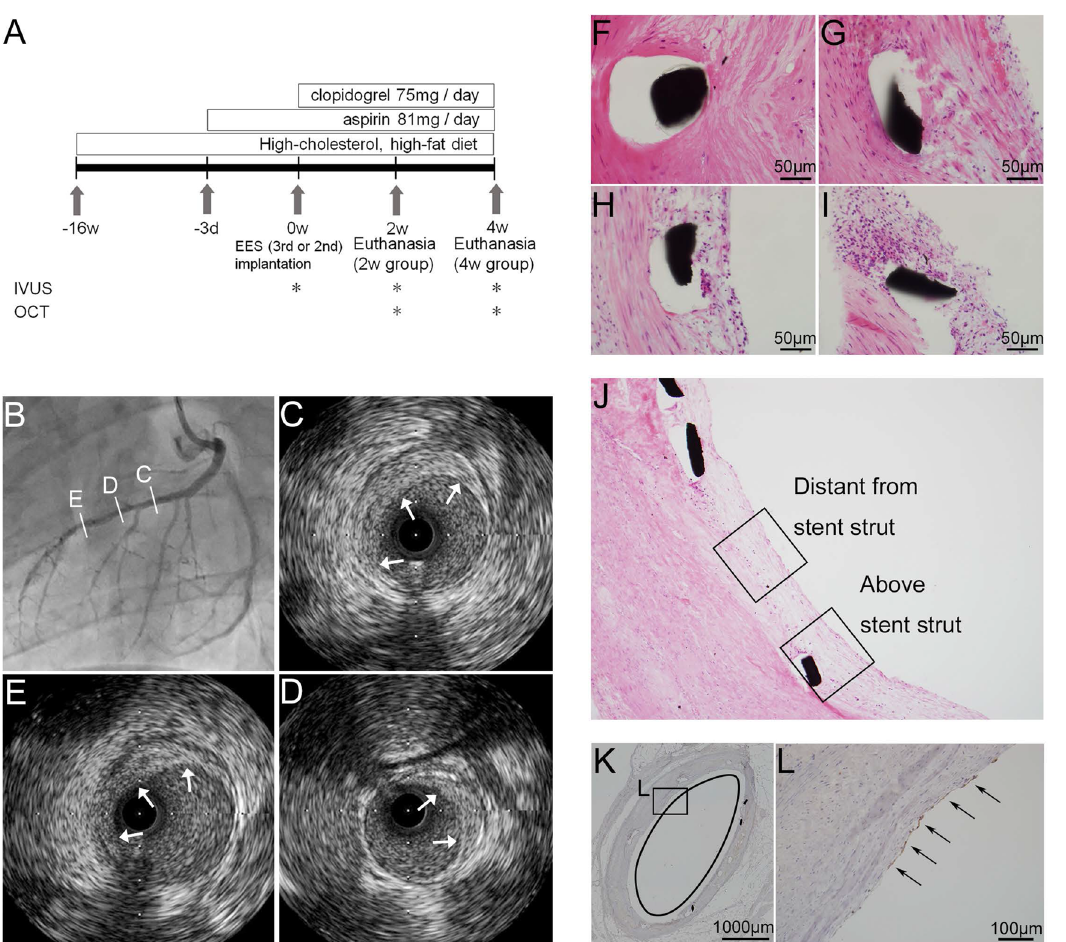
Figure 4. Protocols for animal experimentation and morphometrical analysis. ( A ) Outline of low-density lipoprotein receptor knockout (LDLR −/−) minipigs experiment. ( B – E ) Images of coronary arteries from LDLR −/− minipigs before stent implantation. ( B ) Angiographically, mild stenosis due to arteriosclerosis is visible. ( C – E ) Eccentric fibro-fatty plaques (arrows) are observed on intravascular ultrasound. ( F – I ) Grading of peri-strut inflammation for semi-quantitative analysis. ( F ) Grade 0, absent, few inflammatory cells. ( G ) Grade 1, mild, fewer than 20 inflammatory cells per high power field (HPF). ( H ) Grade 2, moderate, fewer than 50 inflammatory cells per HPF. ( I ) Grade 3, severe, more than 50 inflammatory cells per HPF. ( J ) Tissue characteristics are evaluated for the neointima above the stent strut and the neointima distant from the stent struts. ( K , L ) All sections of stented regions harvested from porcine coronary arteries are immunostained for anti-CD31 antibody. The total luminal circumference ( K ) was measured and the lengths of re-endothelialized regions (arrows in L ) were added up. The ratio of the re-endothelialized region was calculated ( F – J ; hematoxylin–eosin, K , L ; immunohistochemistry for anti-CD31 antibody. C , D *; stent